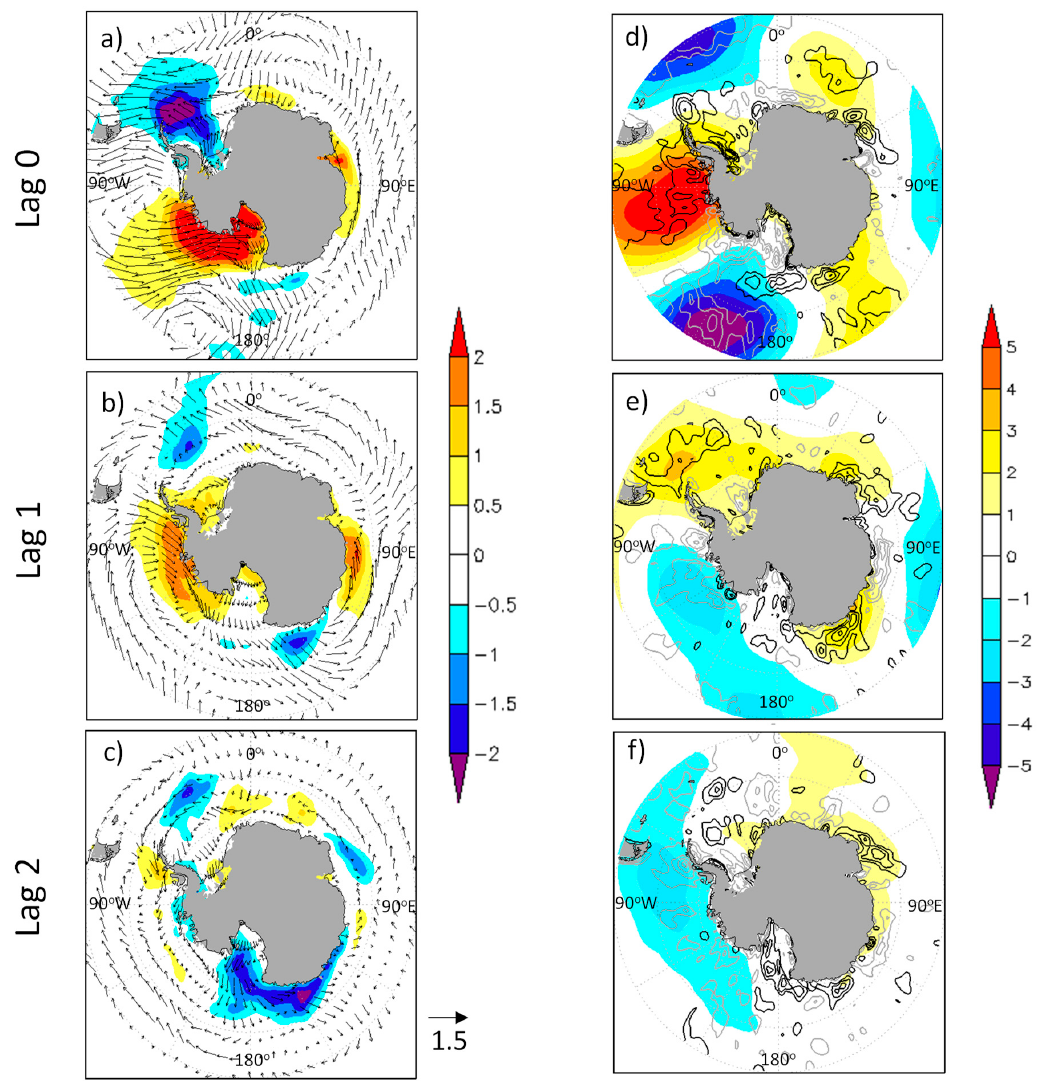
Figure 12. ( a – c ) Air temperature ( o C) and horizontal wind (vectors with scale in the bottom, m s − 1 ) at 1000 hPa, ( c – e ) sea level pressure (hPa) and 1000 hPa wind divergence (x10 − 5 s − 1 with positive / negative values in black / gray lines) anomalies for low moisture sink composites (P20) in April (lag-0) ( a , d ), May (lag-1) ( b , e ) June (lag-2) ( c , f ).